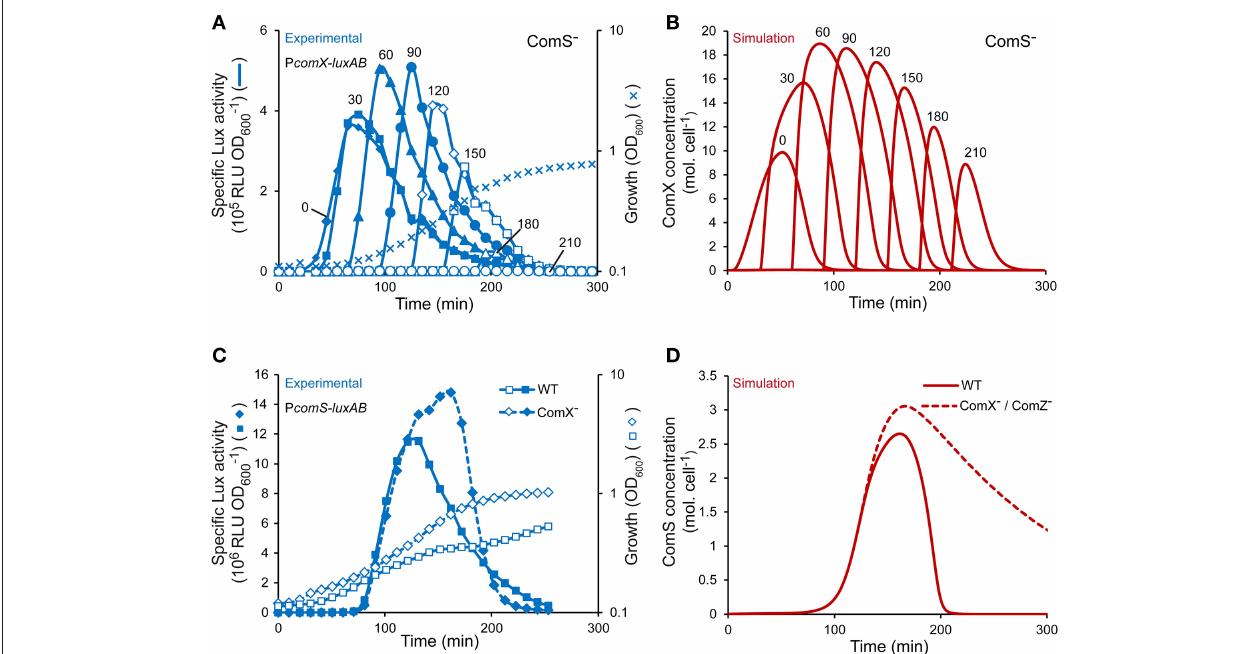
FIGURE 4 | Validation of the dynamics and topology of the ComRS model. (A) Specific activity of P comX upon ComS 17 - 24 addition at different times of growth of a ComS − luminescent reporter strain (TIL1391). The curves show the specific luciferase activity (RLU OD − 1 600 ) of the reporter strain measured directly after addition of 1 µ M ComS 17 - 24 at different times of growth. The growth curve (OD 600 ) of the reporter strain grown in CDML in absence of ComS 17 - 24 is shown. Data were adapted from Gardan et al. (2013). (B) Modeled kinetics of ComX concentrations (molecules (mol.) cell − 1 ) in a ComS − background obtained by simulating the addition of ComS ext (150 mol. cell − 1 ) at different times of growth. The time T expressed in min ( T 0 , 30, 60, 90, 120, 150, 180, and 210) at which ComS 17 - 24 and = ComS ext were experimentally and in silico added, respectively, is indicated above each curve. (C) Comparison of the kinetics of the specific activity of P comS between WT (LF121) and ComX − (LF122) reporter strains (RLU OD − 1 600 ) in CDML growth conditions. (D) Comparison of modeled kinetics of ComS concentrations (mol. cell − 1 ) between WT and ComX − or ComZ − strains. (A,C) The results of one representative experiment are